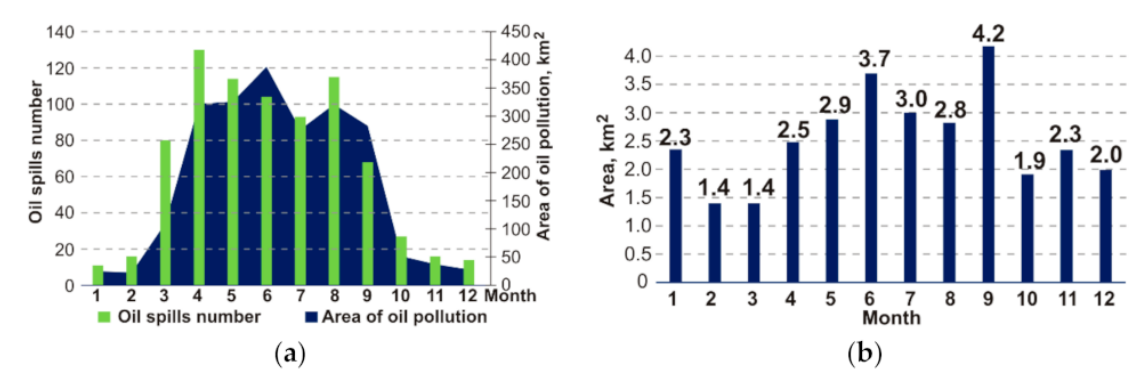
Figure 11. Seasonal variability of the oil spill number and area of oil pollution for 2004–2020 ( a ) and the seasonal variability of the average area of oil spills for 2004–2020 ( b ).